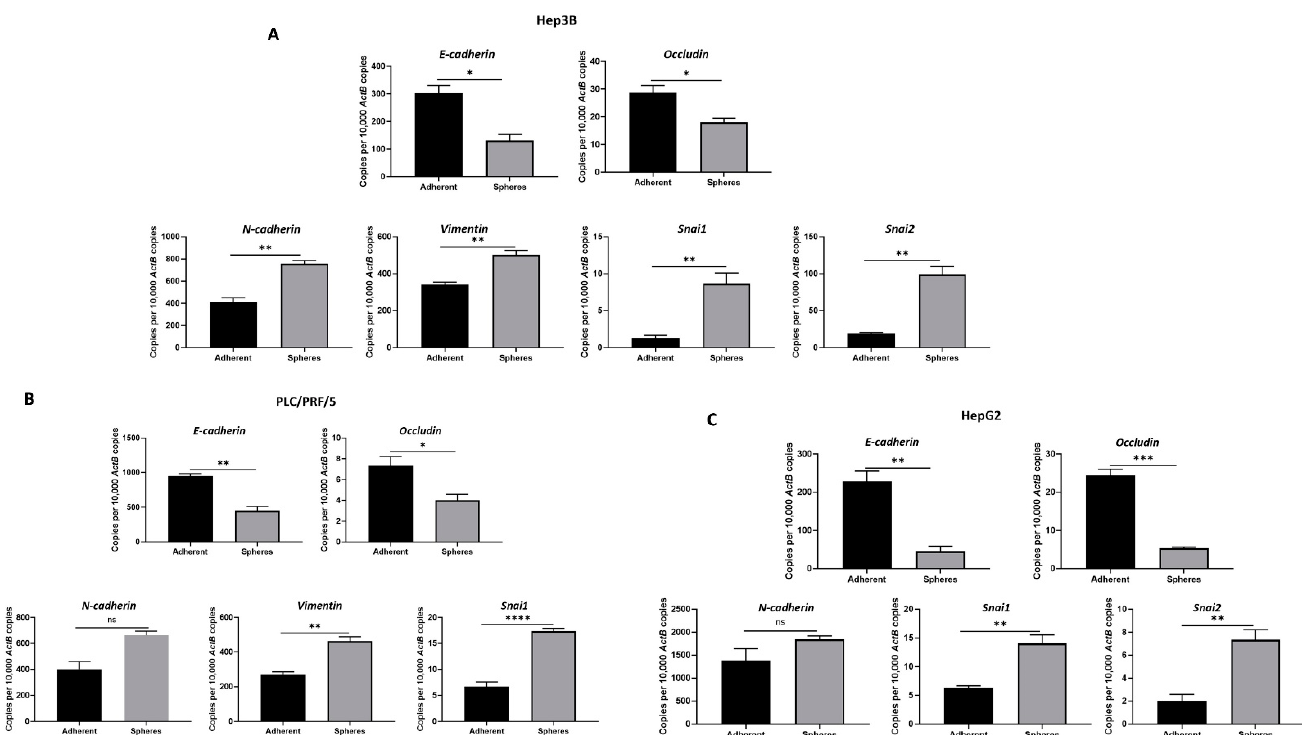
Figure 3. Human HCC-derived spheres exhibit mesenchymal phenotype. qRT-PCR demonstrated ( A ) a decrease in epithelial markers E-cadherin and Occludin and an increase in mesenchymal markers N-cadherin, Vimentin, Snai1 and Snai2 expression in Hep3B-derived spheres compared to adherent cells, ( B ) a reduction in E-cadherin and Occludin expression and an elevation in N-cadherin, Vimentin and Snai1 expression in PLC/PRF/5-derived spheres compared to adherent cells, and ( C ) downregulation of E-cadherin and Occludin and upregulation of N-cadherin, Snai1 and Snai2 in HepG2-derived spheres compared to adherent cells. ( n = 3, * p < 0.05, ** p < 0.01, *** p < 0.005, **** p < 0.001, ns: not significant).